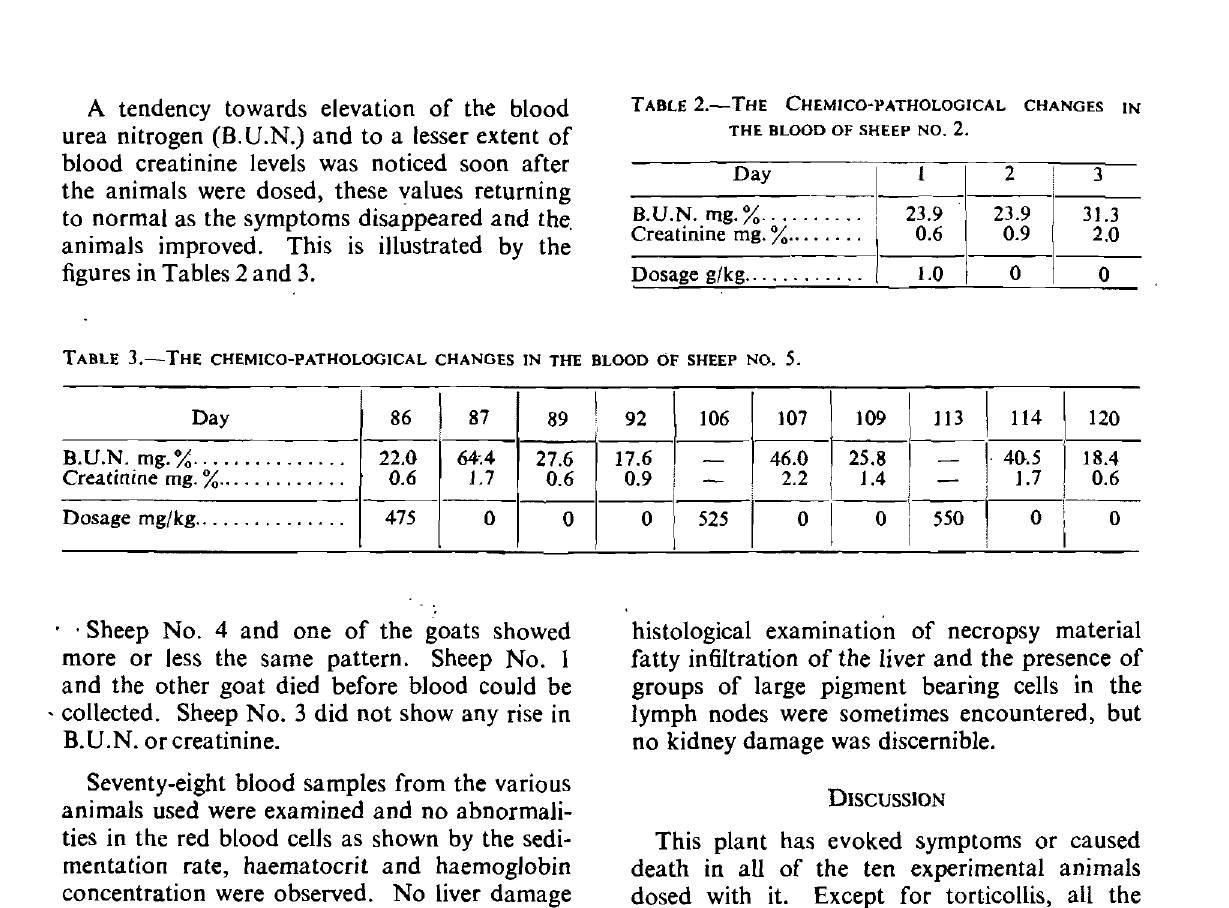
TABLE 2.-THE CHEMICO-PATHOLOGICAL CHANGES IN THE BLOOD OF SHEEP NO.2.